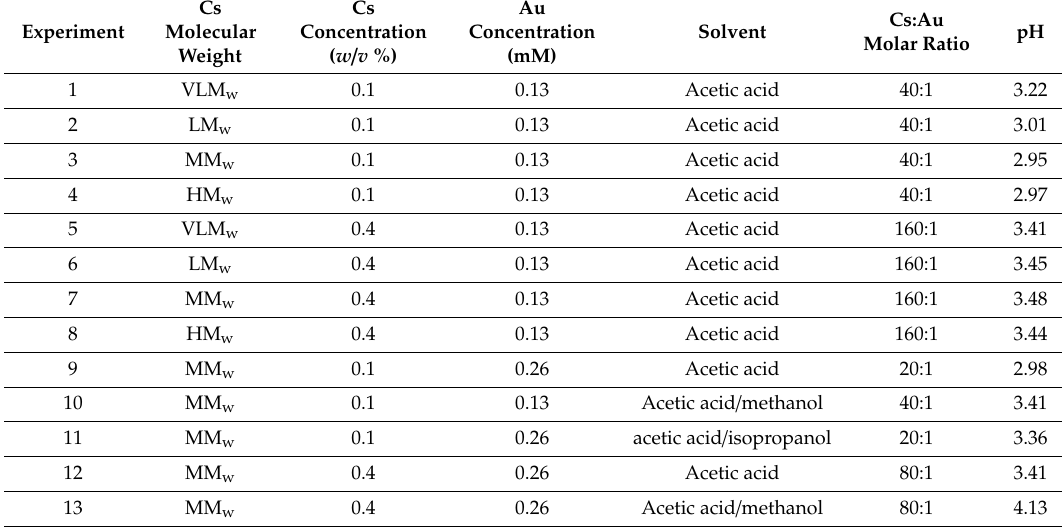
Table1. SummaryoftheexperimentsperformedtoobtainCs-AuNPsandtheirexperimentalparameters.